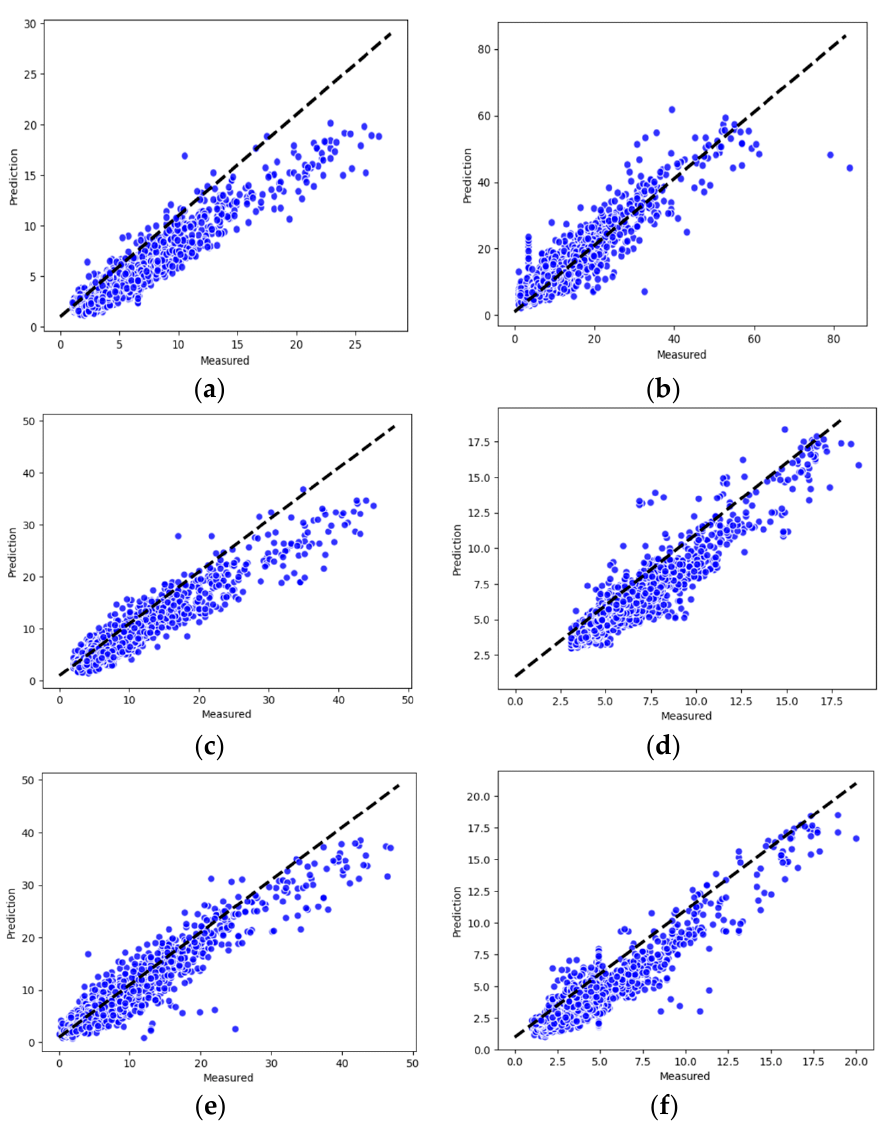
Figure 10. Scatter plot showing the model performance over several locations in Shanghai. ( a ) Chuan- Figure 10. Sca tt er plot showing the model performance over several locations in Shanghai. ( a )